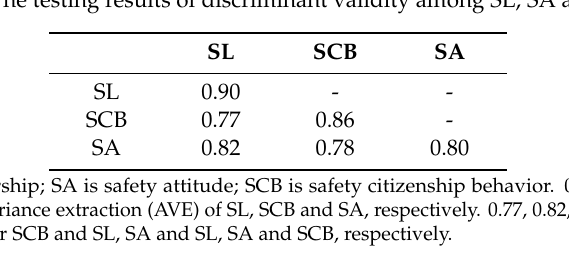
Table 4. The testing results of discriminant validity among SL, SA and